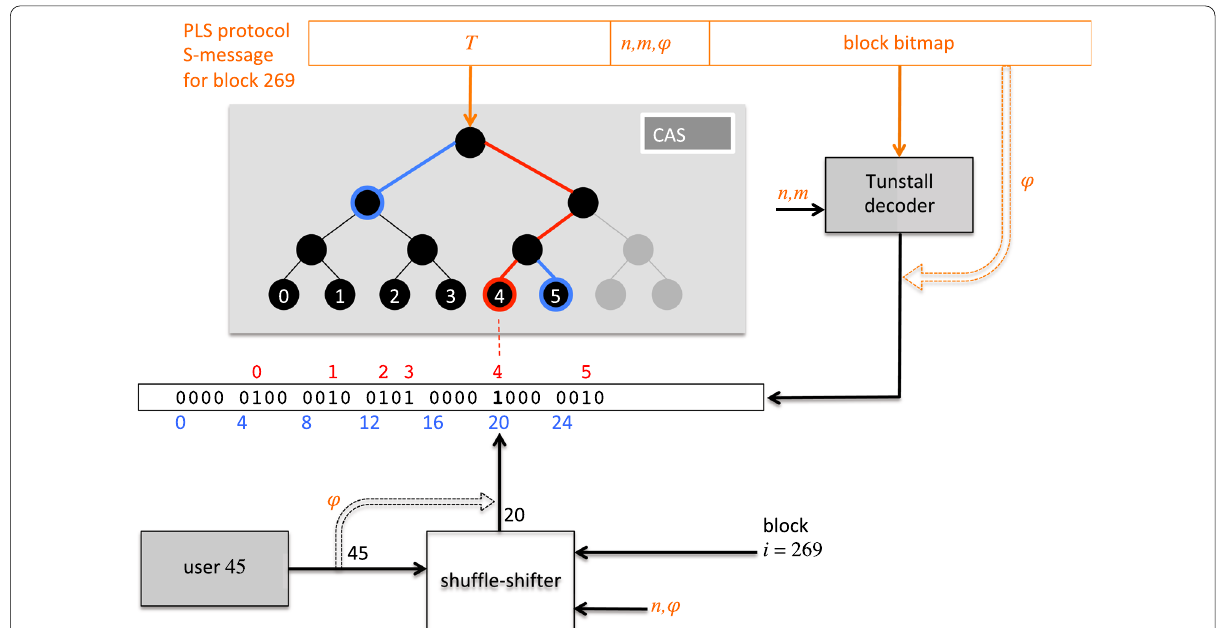
Fig. 9 Retrieving a user record from block 269 for ID = 45 ; for this block m = 5 . Solid arrows show the flow of data, dotted arrows indicate a